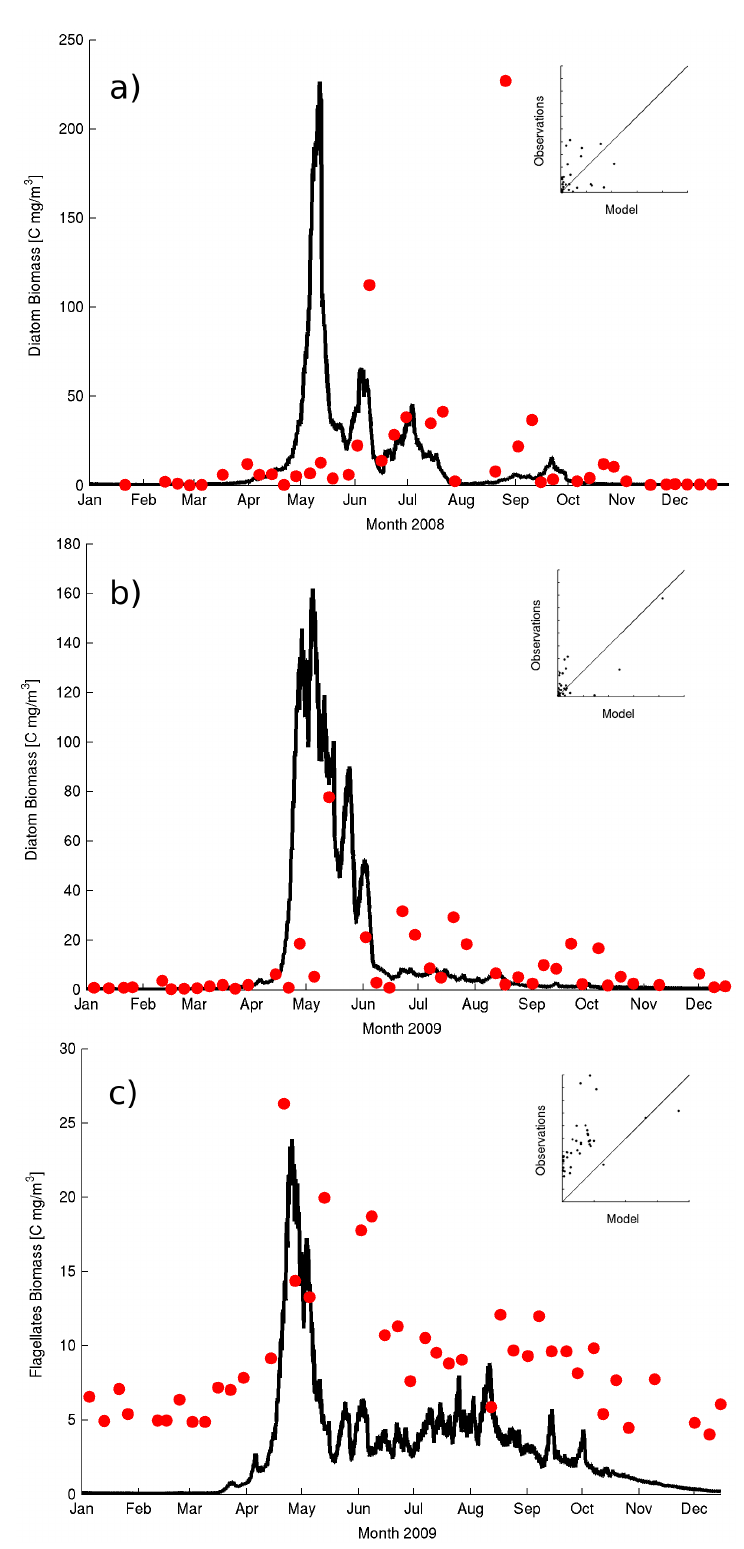
Figure 4. Evolution at 10 m of diatom’s Biomass for ( a ) 2008, ( b ) 2009 and ( c ) flagellates for 2009. The observations correspond to the red dots while the model is the solid line. The one to one plot between observations and model results is included as a thumbnail to illustrate the correspondence between the